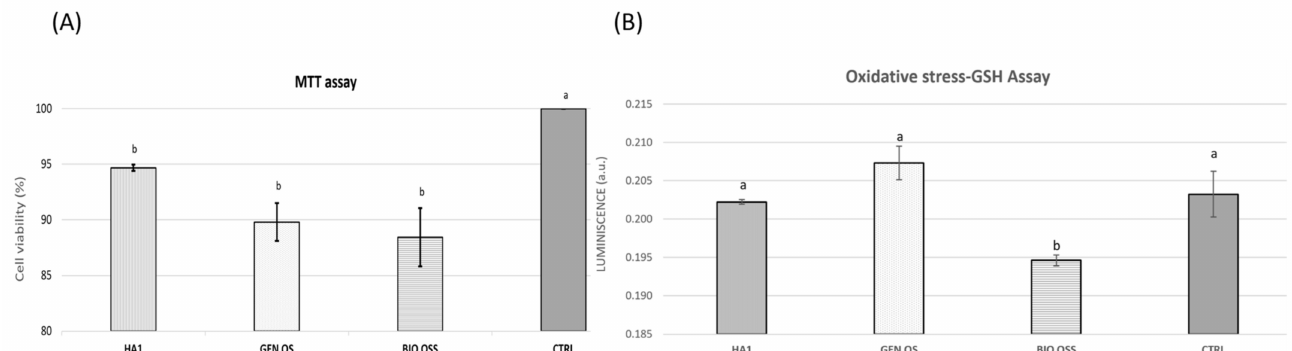
Figure 8. ( A ) MTT assay results (after 72 h incubation) and ( B ) GSH assay showing the oxidative stress of AFSCs cultured in the presence of HA1, Gen-Os, Bio-Oss powders, and CTRL sample (only cells); the results are presented as the mean ± S.D. of 3 replicates; different letters indicate significant differences between each sample; p < 0.05/n (n = 6)-based ANOVA statistical analysis, followed by a two-tailed t -test with Bonferroni post hoc correction ( A